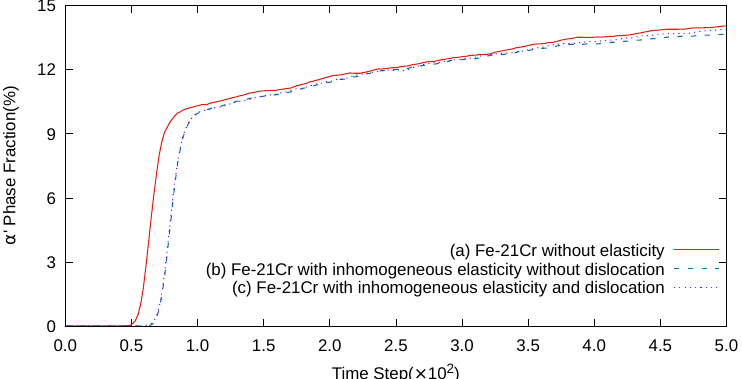
Figure 6. The α ’ phase fraction with respect to the time for the cases of (a) without elasticity, (b) with inhomogeneous elasticity without dislocation, and (c) with inhomogeneous elasticity and